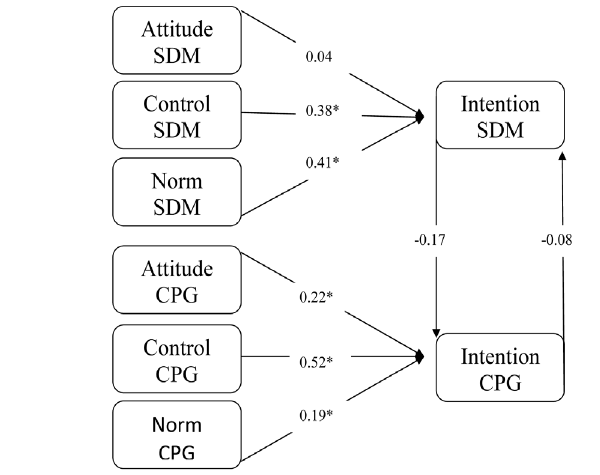
Figure 3. Standardized path analysis coefficients for control group at study exit, showing attitude, perceived behavioral control and subjective norm as predictors of physicians’ behavioral intentions to engage in SDM and to follow CPGs; and showing the influence of the intention to engage in SDM on the intention to follow CPGs and vice versa (vertical arrows).